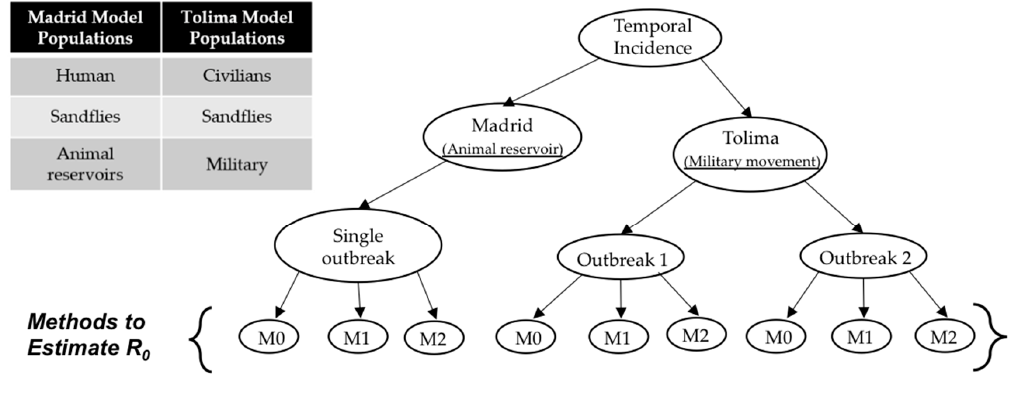
Figure 1 . Types of models and estimation methods used in this article.